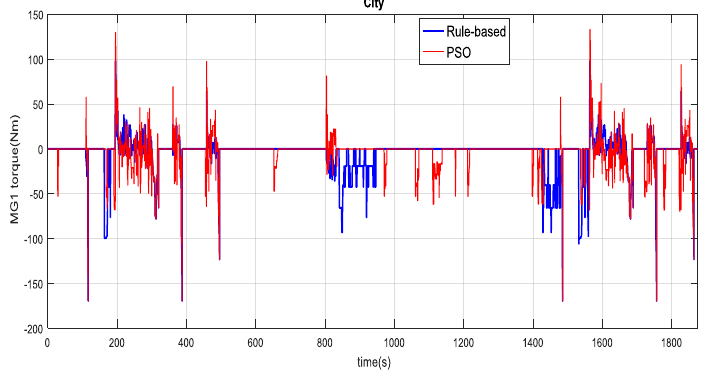
Figure 20. M/G1 torque in the urban driving cycle.